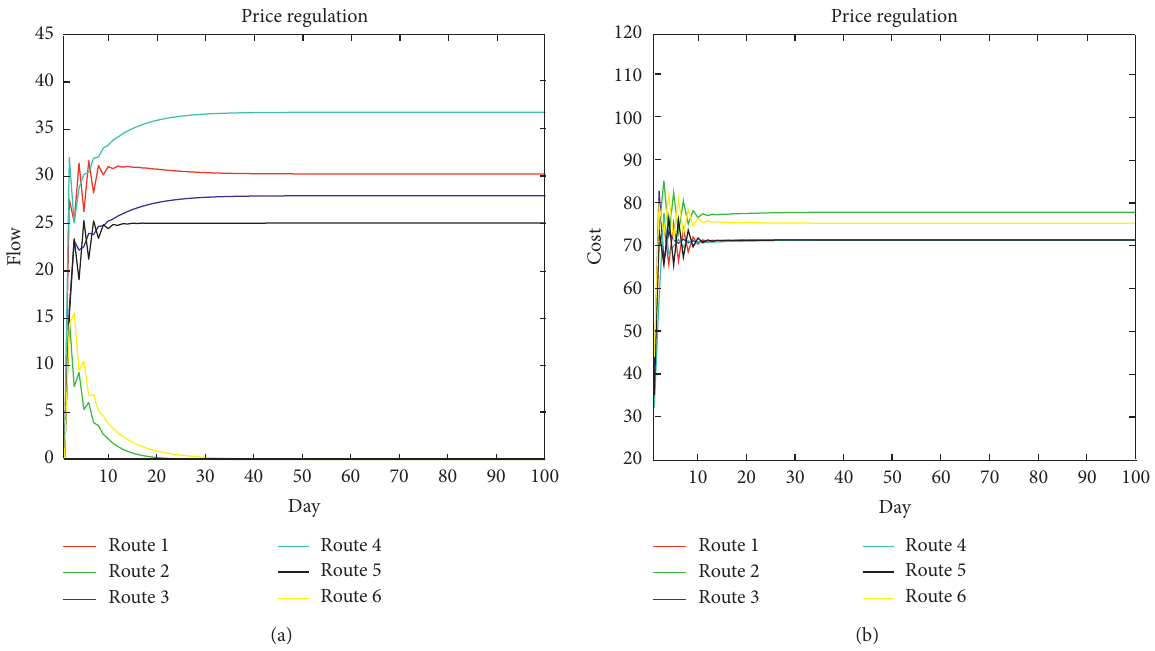
Figure 2: Evolutionary trajectories of route flows (a) and route travel costs (b) for travellers in the first group.